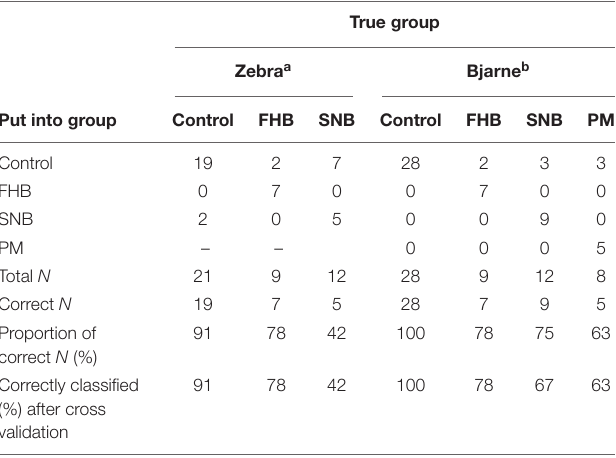
TABLE 9 | Summary of classification of fungal diseases on ‘Zebra’ and ‘Bjarne,’ when data from 7, 14, and 21 days after inoculation was